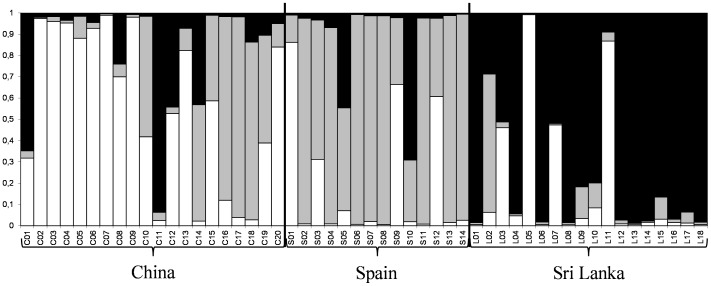
Assignment tests of accessions to populations.The estimated number of populations (parameter K) was set to 3 in the STRUCTURE software (Pritchard et al., 2000). Accessions are organized according to their origin (China, Spain, and Sri Lanka). The three populations are named according to the origin of the majority of the accessions constituting each population (CH for China, SP for Spain, and SL for Sri Lanka). Each accession is represented by a horizontal line, which is partitioned into colored segments (white for the CH population, grey for the SP population, and black for the SL population).